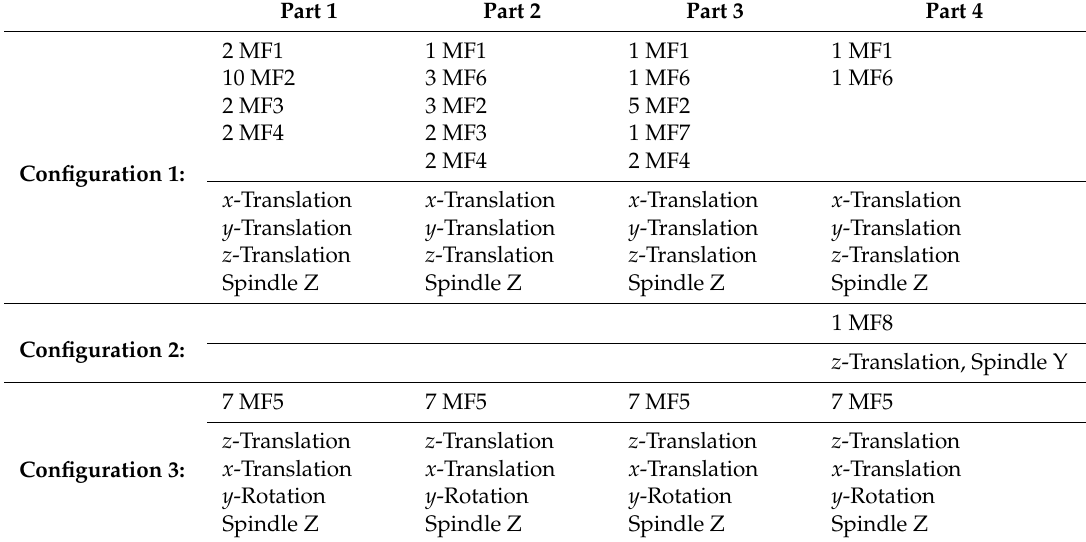
Table 3. Clustered machine configurations.